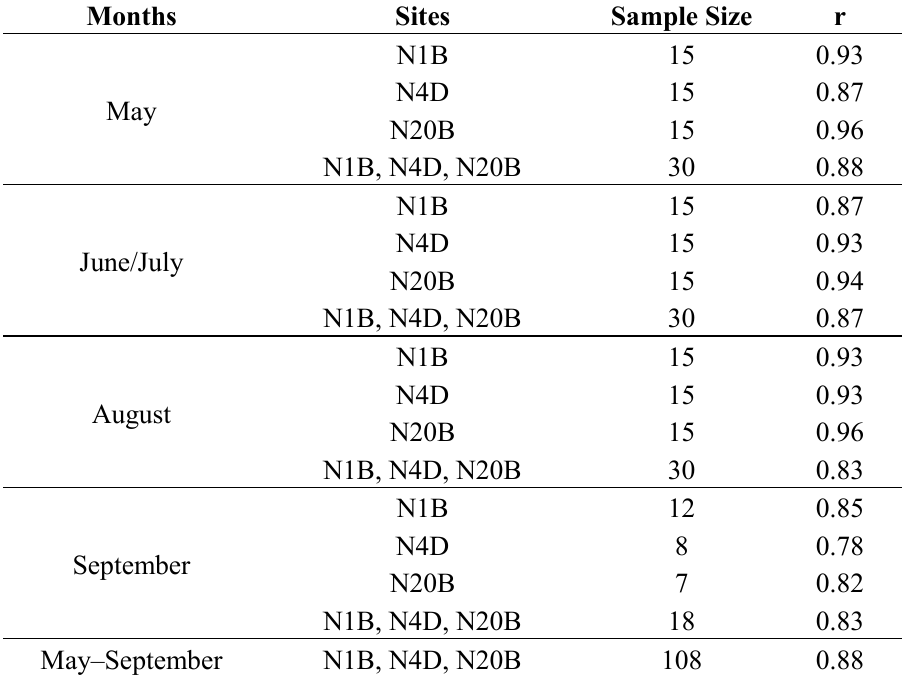
and the SDVI for the field-collected data. can